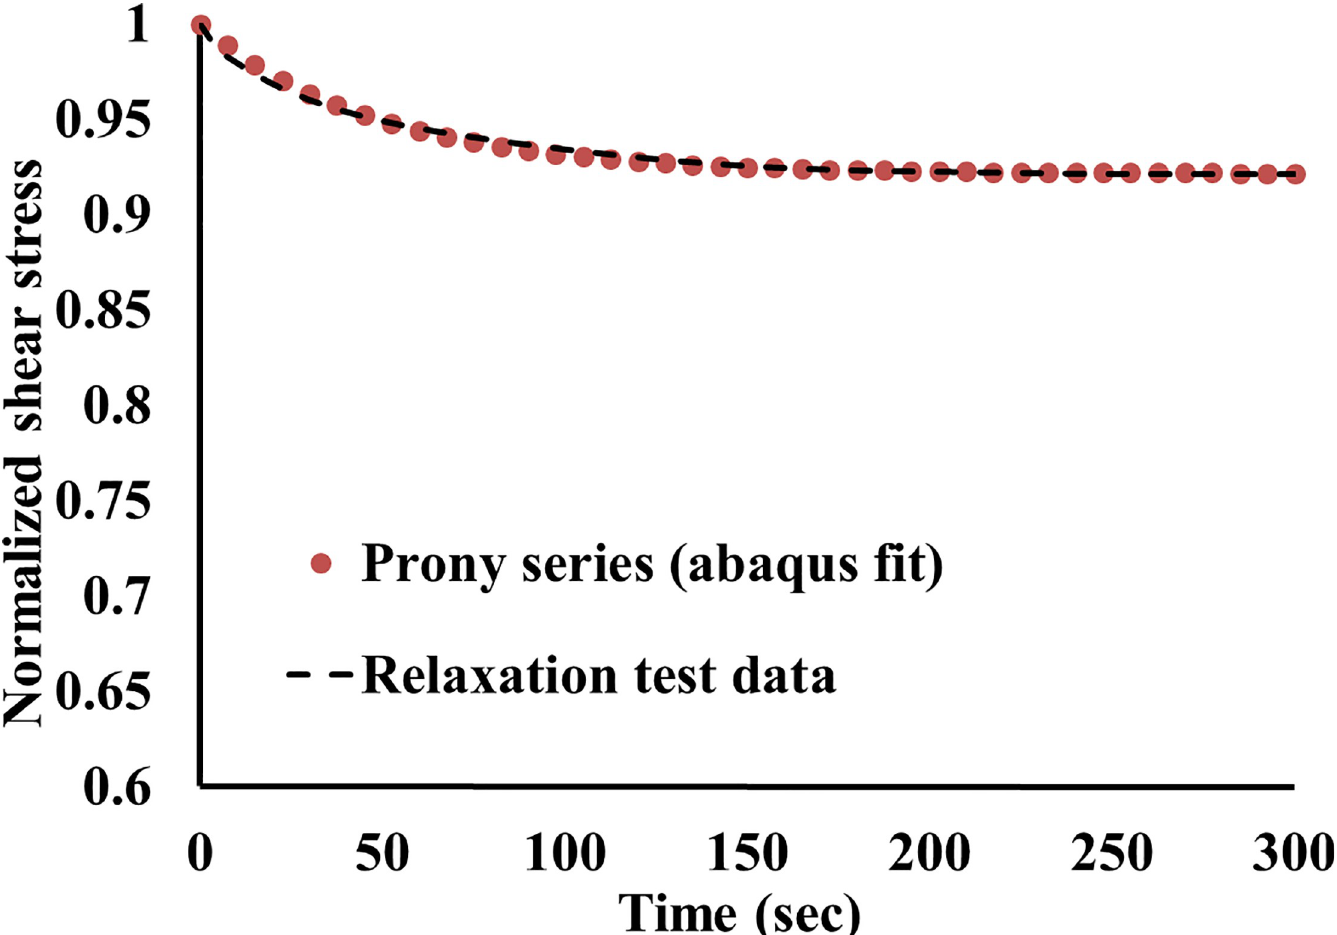
Fig 7. Long term gel response. Comparison between the relaxation test data and the Prony series function.